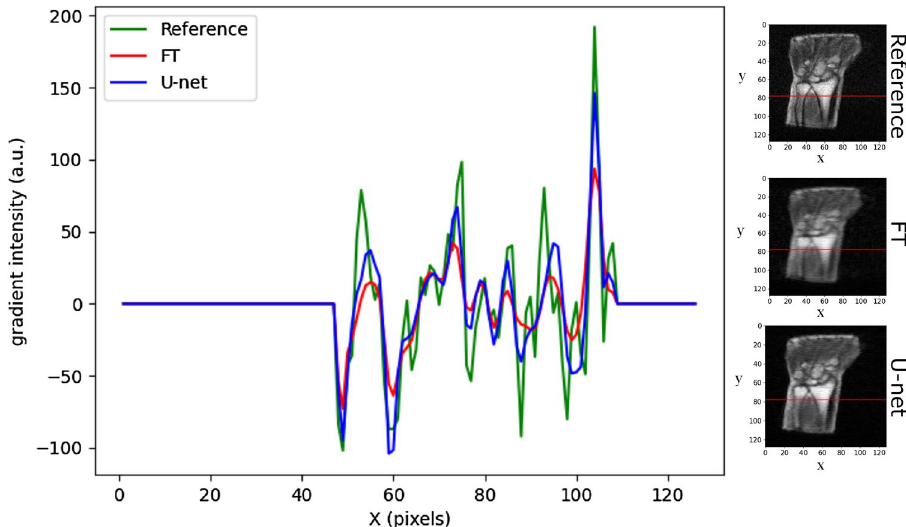
Figure 3. Example illustrating the model performance in preserving edges. Gradient profiles along the red line in reference (green), FT (red) and DL (blue) magnitude images with a fivefold acceleration rate (CL = 7, σ y = 0.10